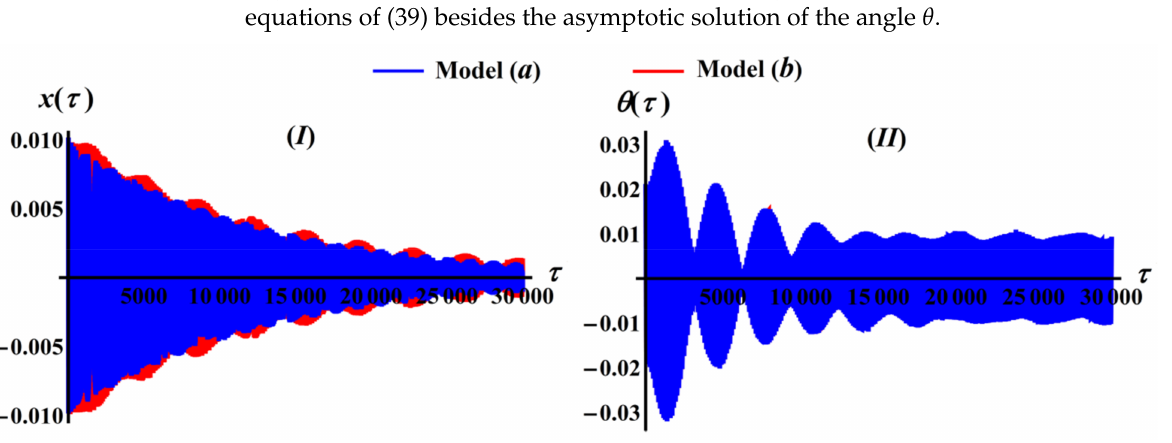
Figure 4. The time histories of the solutions: ( I ) x ( τ ) and ( II ) θ ( τ )